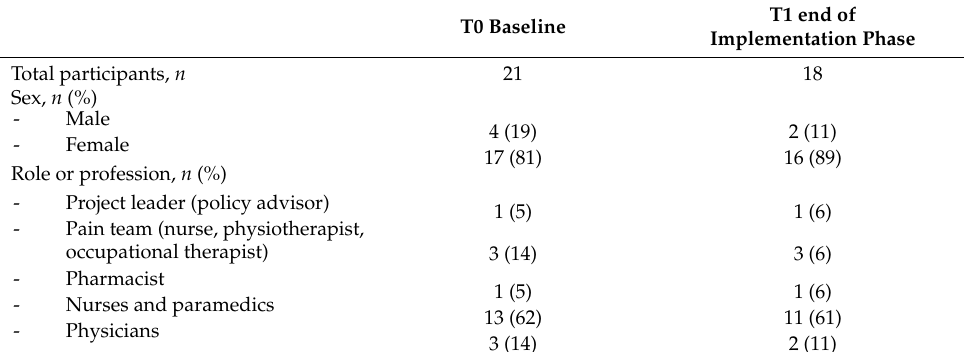
Table 1. Participant